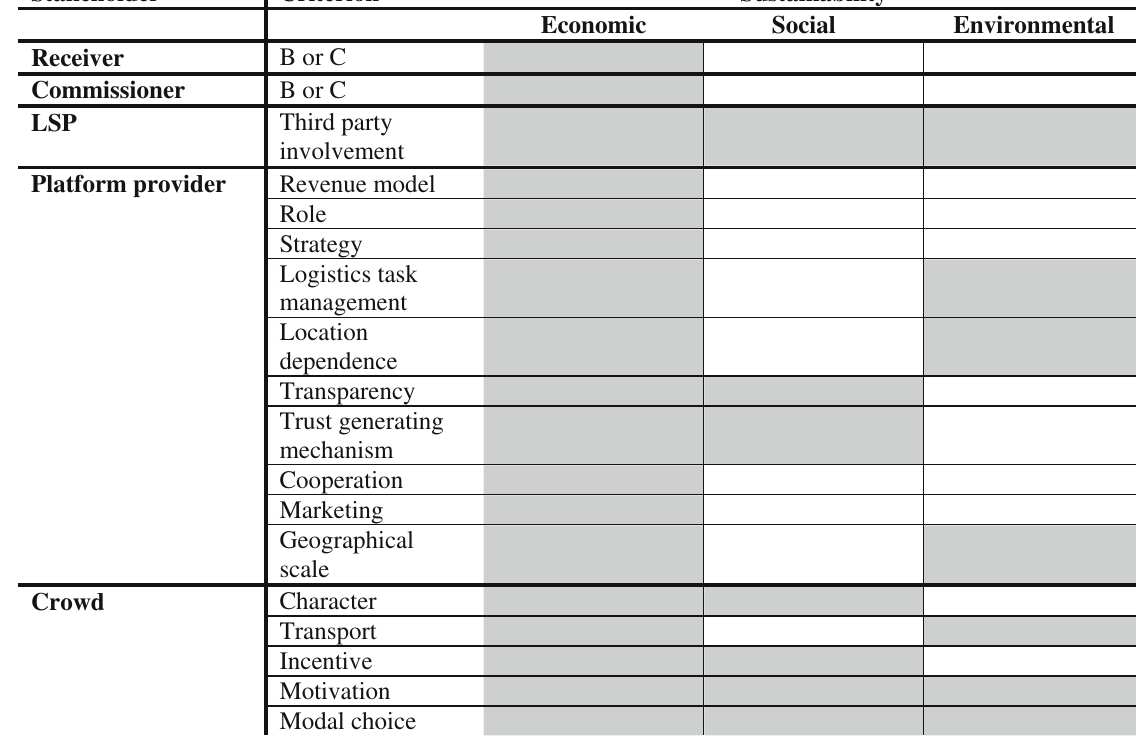
Crowd logistics sustainability implications Stakeholder